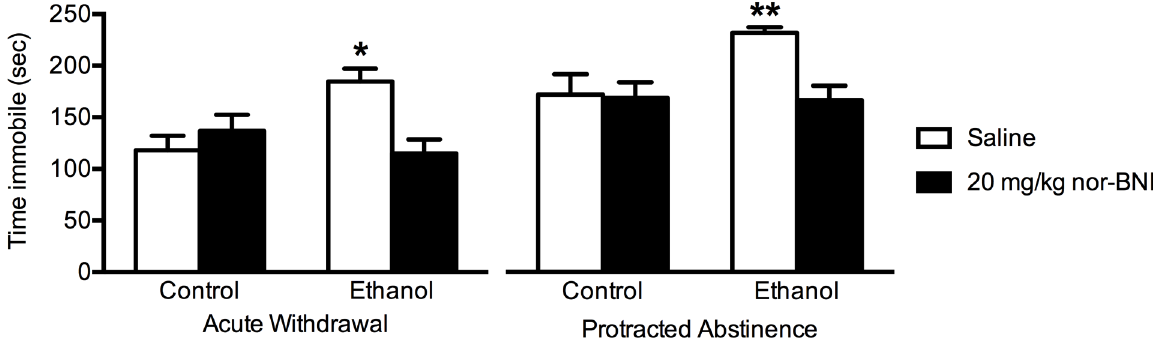
Fig 1. Attenuation of increased immobility during in the forced swim test by nor-BNI in ethanol-dependent rats during acute withdrawal and protracted abstinence. Rats (n = 6-9/group) were exposed to an ethanol or control liquid diet for 28–30 days. In the acute withdrawal condition, rats were exposed to 10 minutes of forced swim stress 24 hours after removal of the diet and then injected with nor-BNI (20 mg/kg, i. p.) or saline immediately following this procedure. Rats were then tested in the forced swim test 24 hours later for 5 minutes. In the protracted abstinence condition, rats were left undisturbed for 3 weeks after removal of the liquid diet. At the end of this period, rats were exposed to 10 minutes of forced swim stress and then injected with nor-BNI (20 mg/kg, i.p.) or saline in a similar manner to the acute withdrawal condition. 24 hours later, rats were examined in the forced swim test for 5 minutes. Data are expressed as mean + SEM. (cid:3) p < 0.05 compared to all other groups in the acute withdrawal condition, Tukey’s test. (cid:3)(cid:3) p < 0.05 compared to all other groups in the protracted abstinence condition, Tukey’s